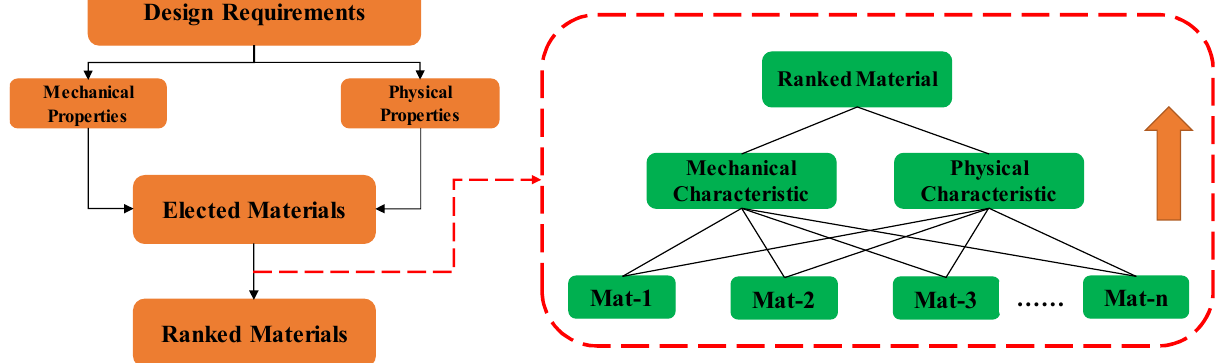
Figure 3. Material selection process.